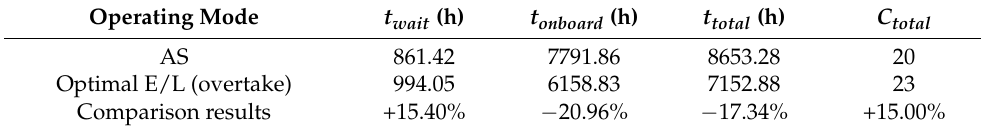
Table 7. Comparison of the results for the optimal E/L (overtake) and AS modes for Jiangjin Line.